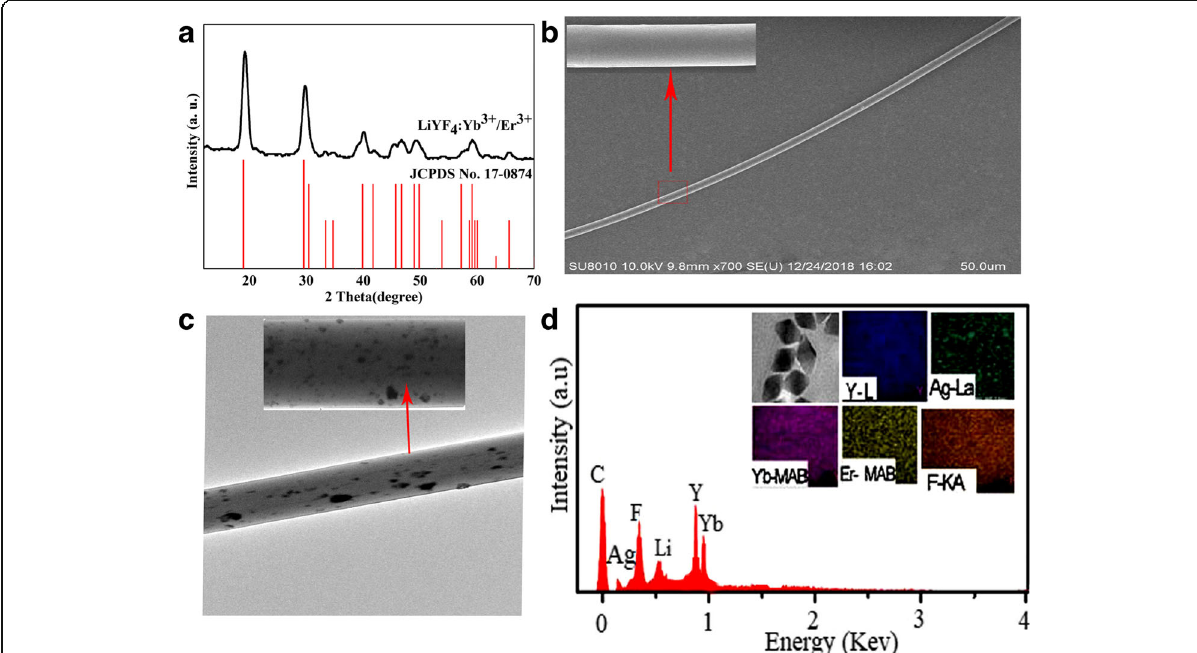
Fig. 3 Characterization process of LiYF 4 :Yb 3+ /Er 3+ and Ag co-doped microfibers. a XRD of LiYF 4 :Yb 3+ /Er 3+ . b SEM of Ag co-doped microfiber. c